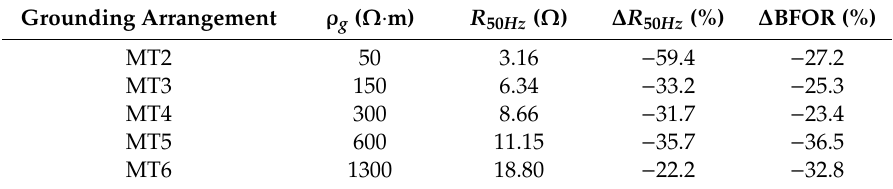
Countermeasure 1: improvement of the lightning performance for di ff erent soil resistivity values.